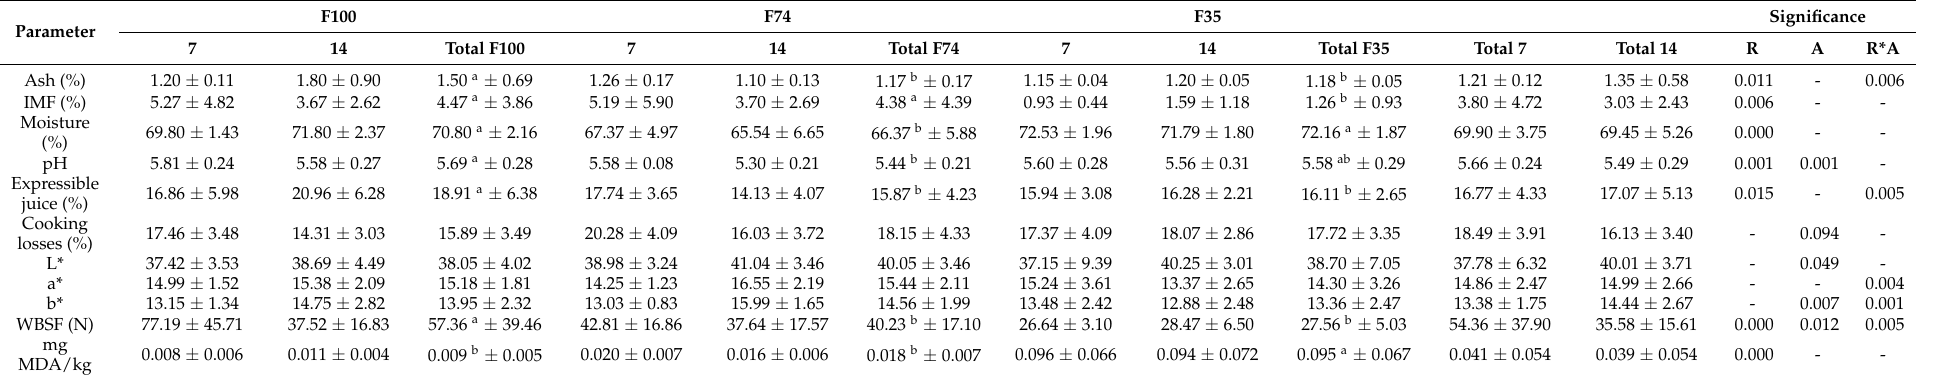
Table 2. Physicochemical parameters depending on the rearing system and ageing time (mean ±